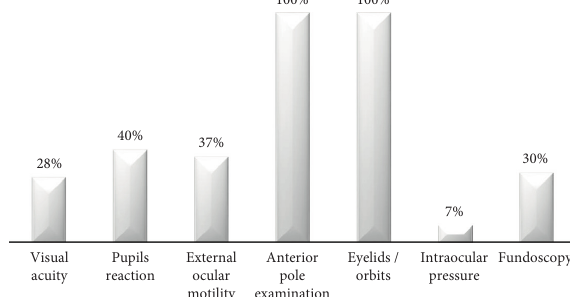
Figure 2: Ophthalmic examinations performed in children.